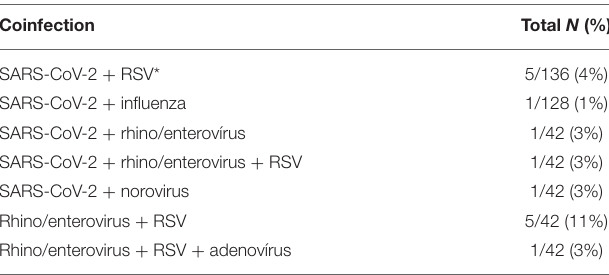
TABLE 3 | Coinfections at the hospital admission. TABLE 4 | Variables associated with COVID-19 diagnosis – multivariate